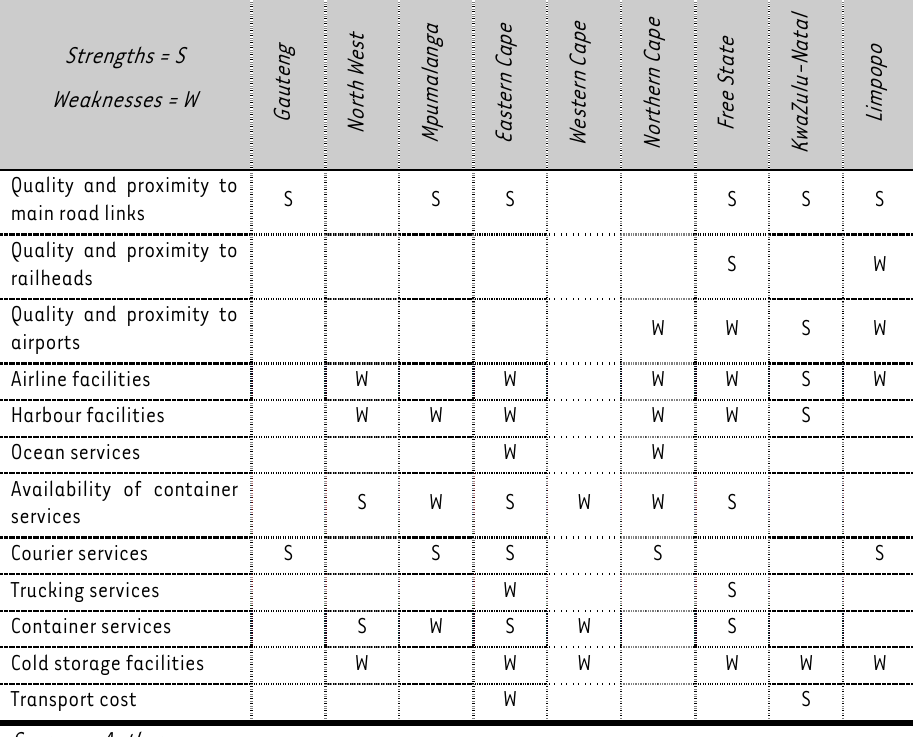
TABLE 2: Effect of Location on Competitiveness: Transport Issues Strengths =